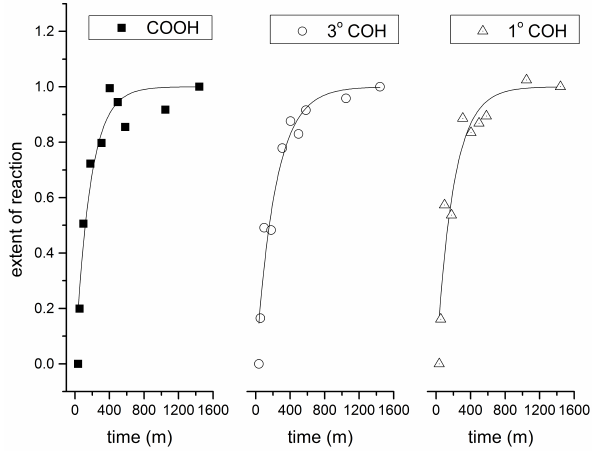
Fig. 7. Sample kinetics plots for single experiment (Solution 1). Solid lines denote first order product formation nonlinear regression results.